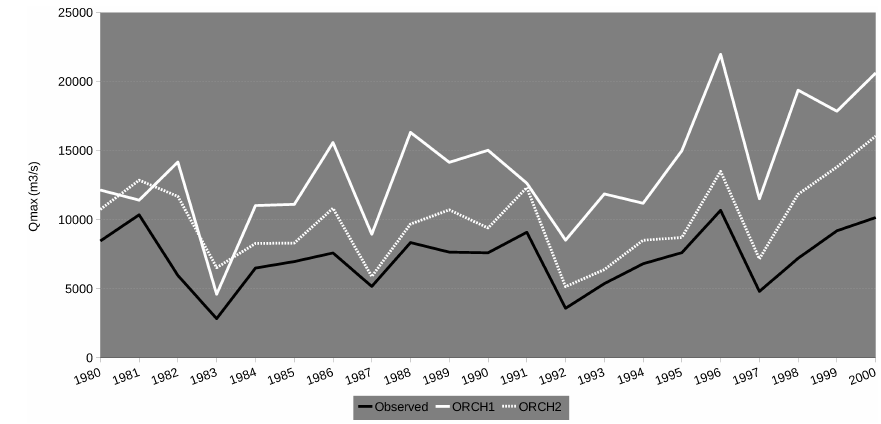
Fig. 13. Interannual variation of maximal monthly discharge (m 3 s − 1 ) at Caracarai for simulations ORCH1 and ORCH2 compared to observations, over the time period 1980–2000.